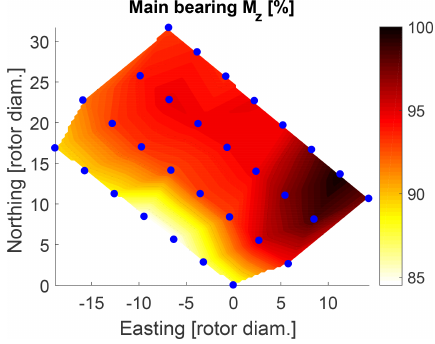
Figure 21. Coefficient of determination R 2 of power time series prediction under normal operation.